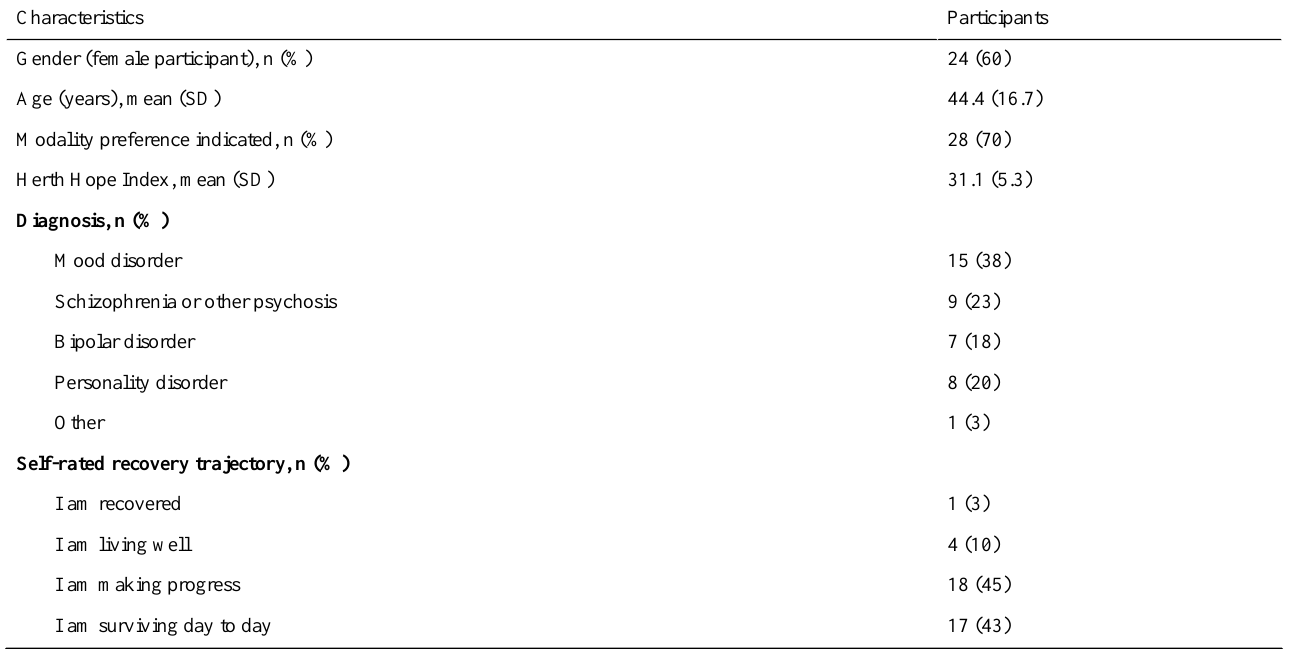
Table 2. Characteristics of participants of study 3 (N=40).